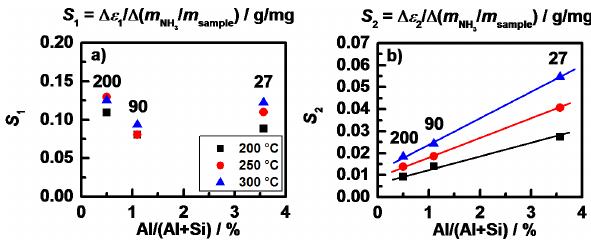
Figure 6. Sensitivities of the dielectric permittivity of H-ZSM-5 zeolites to ammonia: (a) S 1 for ε 1 , and (b) S 2 for ε 2 , for Si / Al ratios of 27, 90 and 200 at temperatures of 200, 250 and 300 ◦